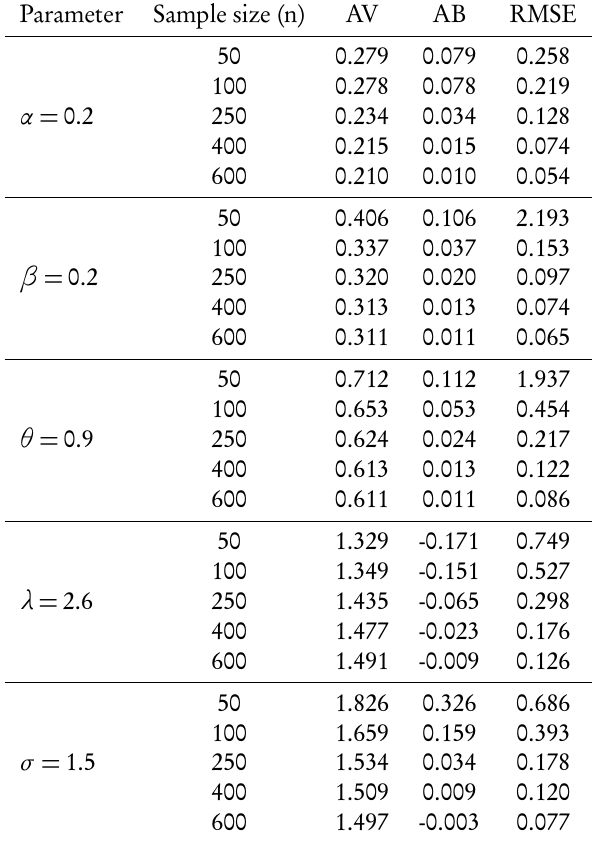
Simulation results for ( α , β , θ , λ , σ ) = ( 0.2,0.3,0.6,1.5,1.5 )